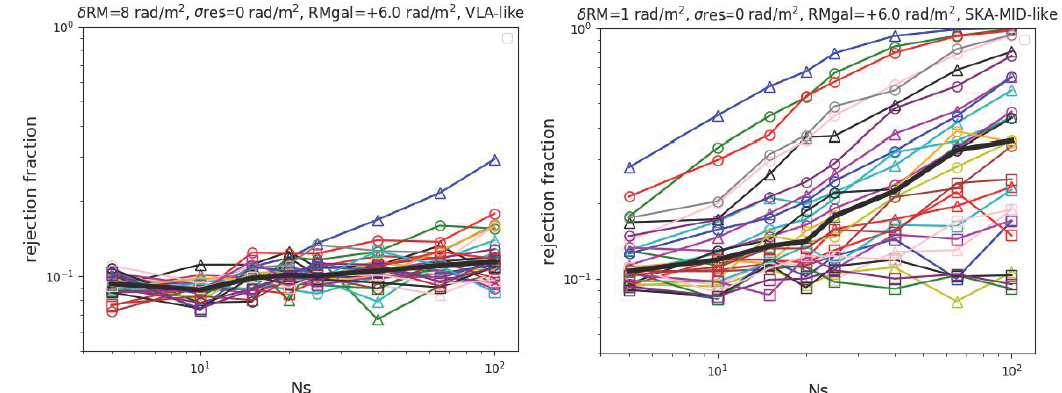
Figure 2. Rejection fraction for an increasing number of detected RMs calculated for all the simulated filaments in the primordial seeding scenario, for an idealized scenario in which we set σ res to 0 rad/m 2 for the residual RM on background sources. Different colors mark different filaments, different marks point to different simulated clusters, while the solid black line show the median for fixed N S . ( Left ) JVLA-like parameters; ( Right ) SKA-MID-like parameters. Color and mark codes of filaments are conserved through all the plots in this work.